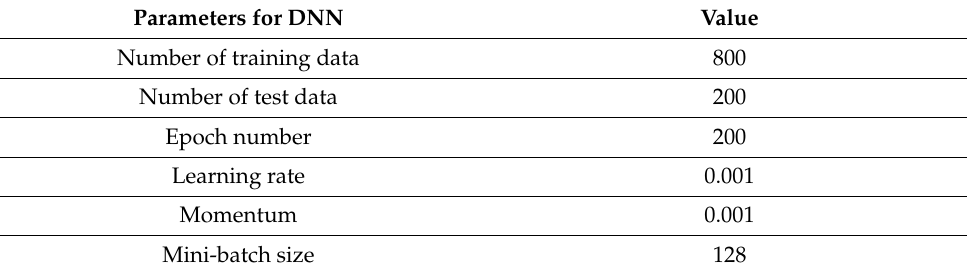
Table 4. Parameters for DNN simulation.